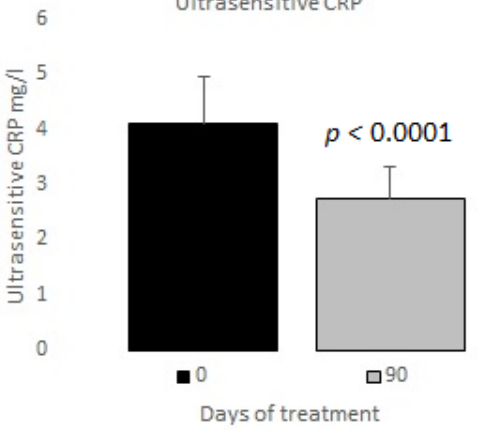
Figure 2. Ultrasensitive C reactive protein basal vs. 90 days of treatment with resveratrol, piperine and alpha-tocopherol in MetS patients.